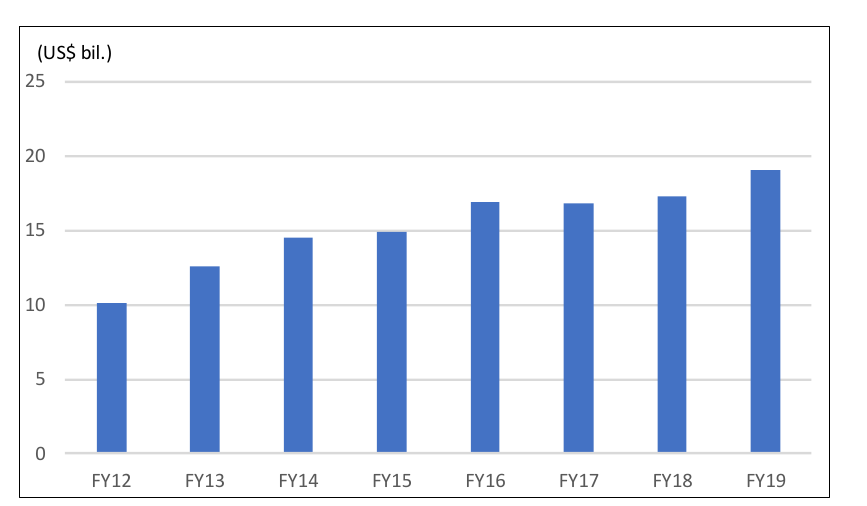
Figure 1. Pharmaceutical Exports from India (IBEF Pharmaceuticals 2019 [13]).